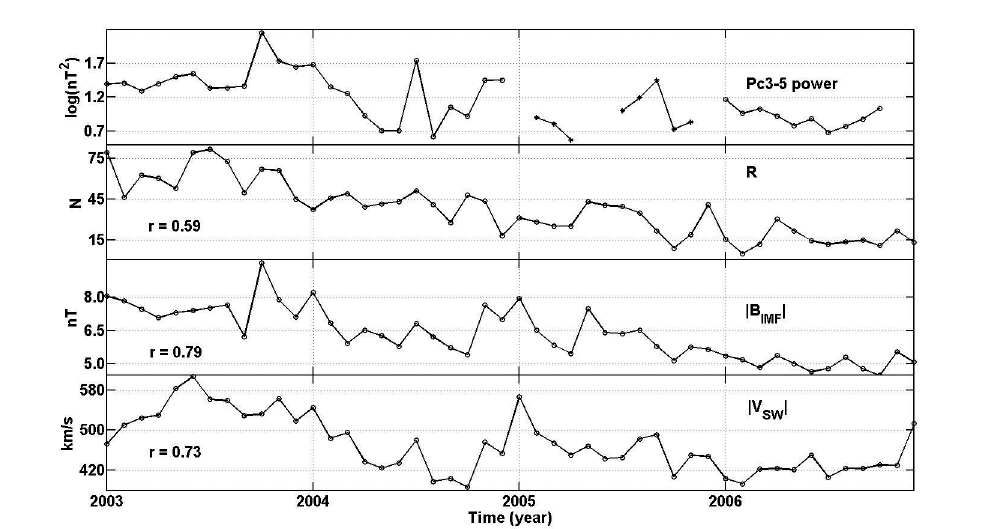
Fig. 2. Monthly averages of ULF power and interplanetary parameters. From top to bottom: Pc3-5 power of the horizontal component, sunspot’s number, IMF amplitude and SW speed.